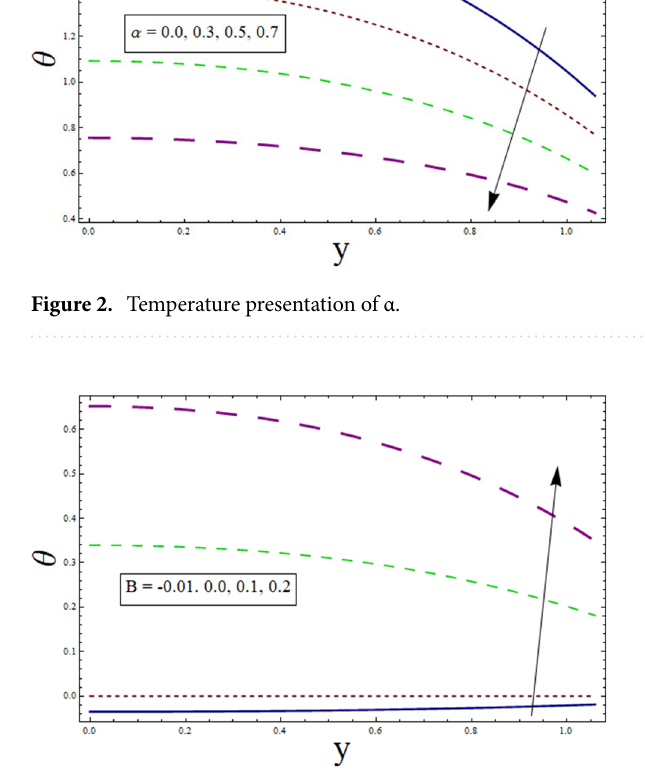
Figure 3. Temperature presentation of B.